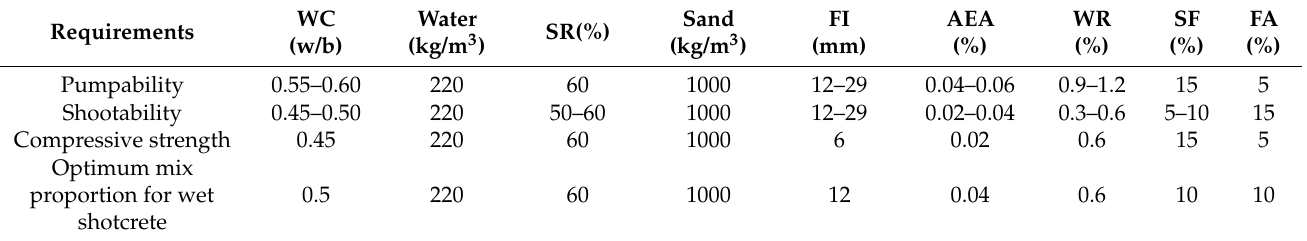
Table 5. Mixture proportions recommended for meeting various shotcrete